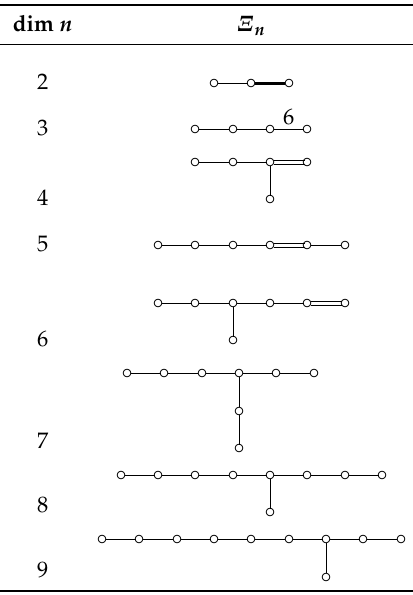
Table 1. Some non-compact hyperbolic Coxeter simplices. dim n Ξ